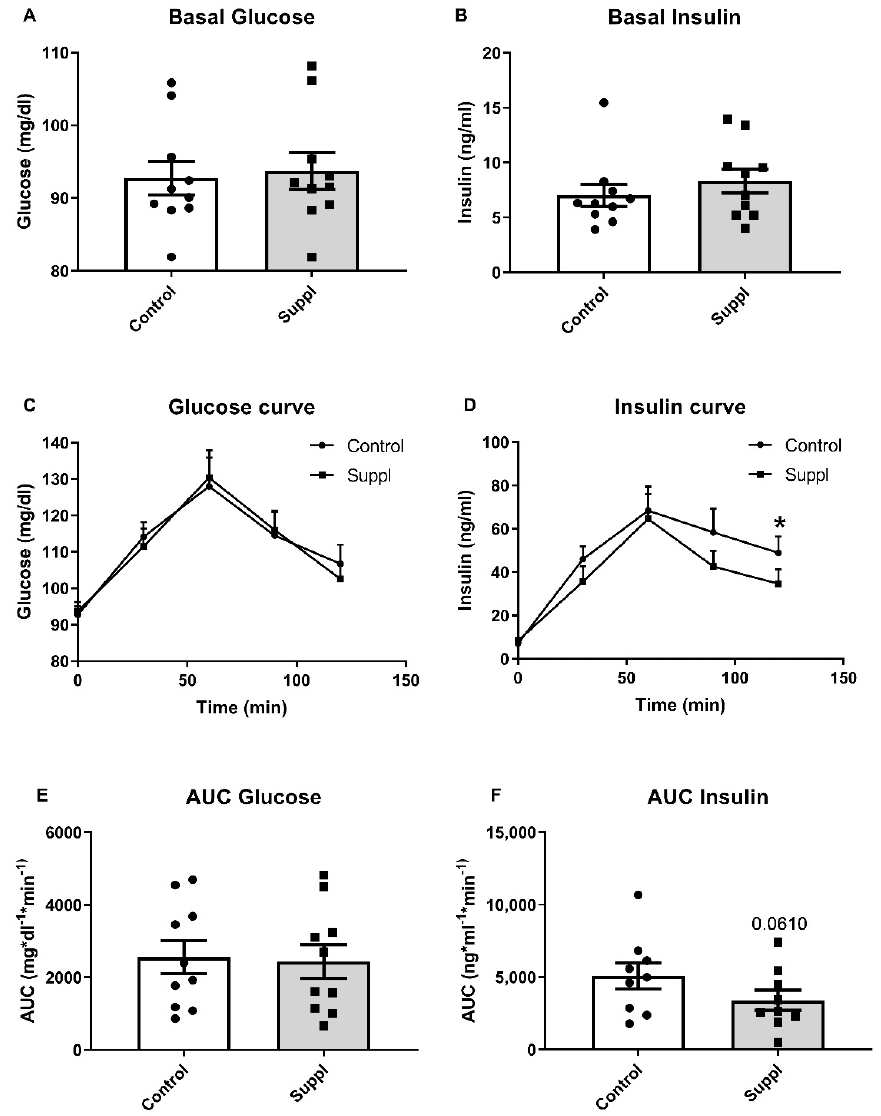
Figure 3. Glucose and insulin results after short-term fresh blueberry supplementation (Suppl). ( A ) Basal fasting glucose levels. ( B ) Basal fasting insulin levels. ( C ) Glucose curve after 150 g of white bread consumption. ( D ) Insulin curve after 150 g white bread consumption. ( E ) Area under the curve (AUC) of plasma glucose after 150 g of white bread consumption. ( F ) Area under the curve (AUC) of plasma insulin after 150 g of white bread consumption. * p < 0.05 vs. control.